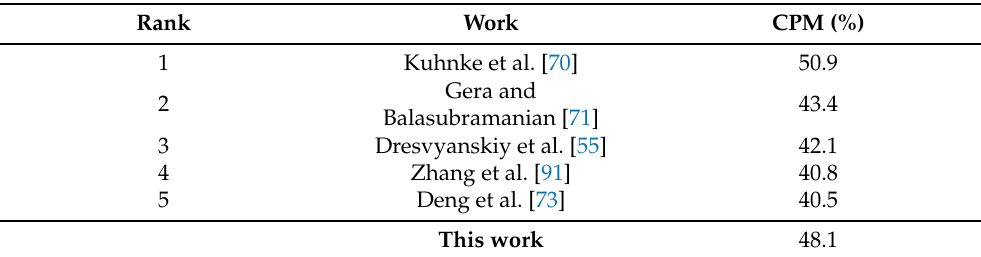
Table 7. Top-5-performing systems at the ABAW-FER Challenge 2020 compared to the performance of our